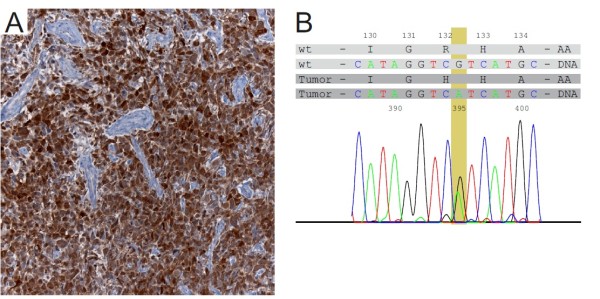
GBM sample with an IDH1 R132H mutation demonstrated by IHC and sequencing.